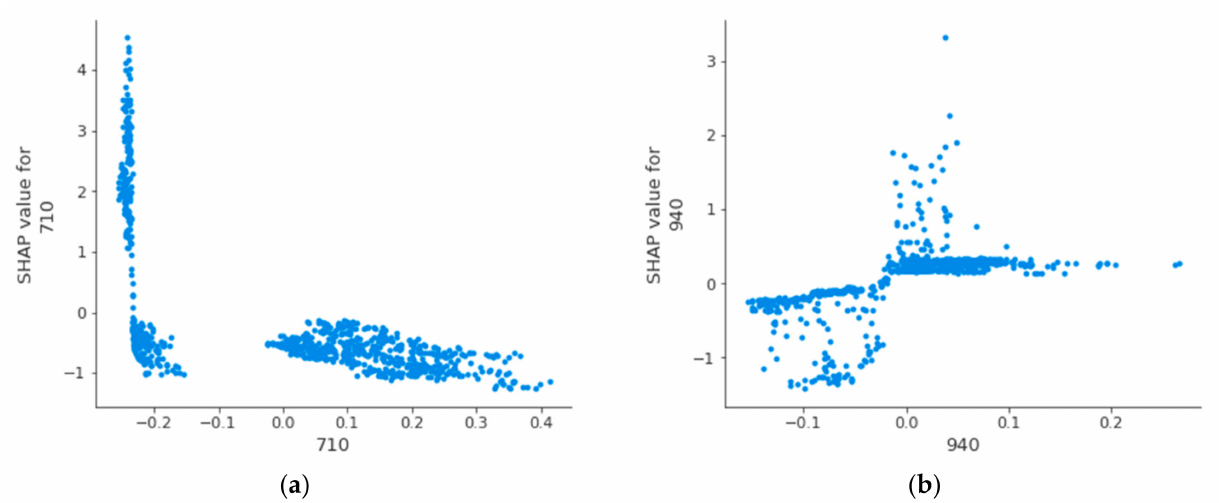
Figure 14. Shapley additive explanations (SHAP) value transition over feature value of random forest regressor to estimate NC. ( a ) SHAP value for the feature of 710 nm; ( b ) SHAP value for the feature of 940 nm. X-axis represents feature value while Y-axis represents SHAP